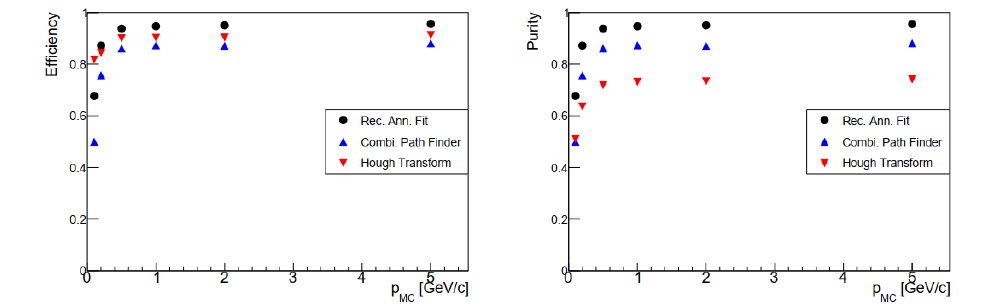
Figure 6: The e ffi ciency and purity for the recursive annealing fit (black dots), the combina- torial path finder (blue triangles up), and the Hough transformation (red triangles